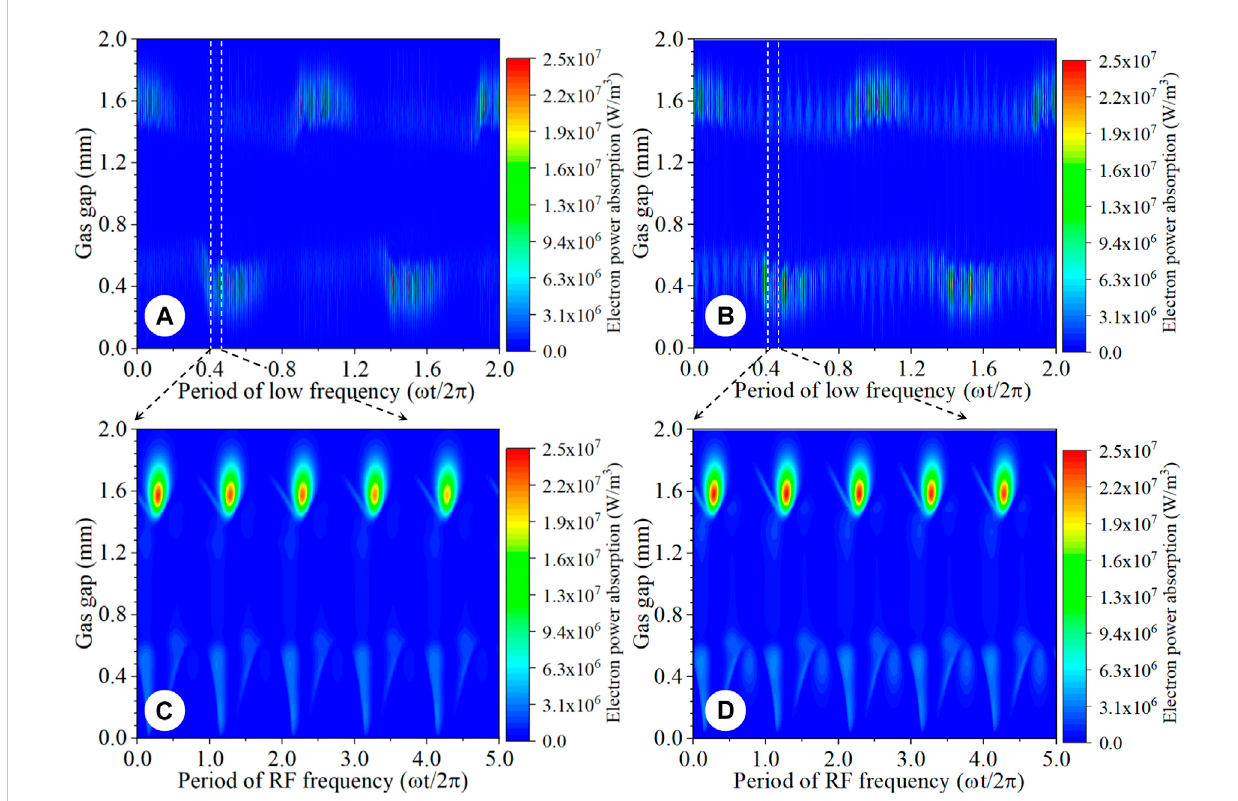
FIGURE 8 Spatio-temporal pro fi les of the power absorption in two low-frequency periods, for (A) V L = 1300 V/ V H = 250 V and (B) V L = 1300 V/ V H = 350 V, respectively. And, (C, D) are fi ve RF period enlargements in the selected region corresponding to (A, B),